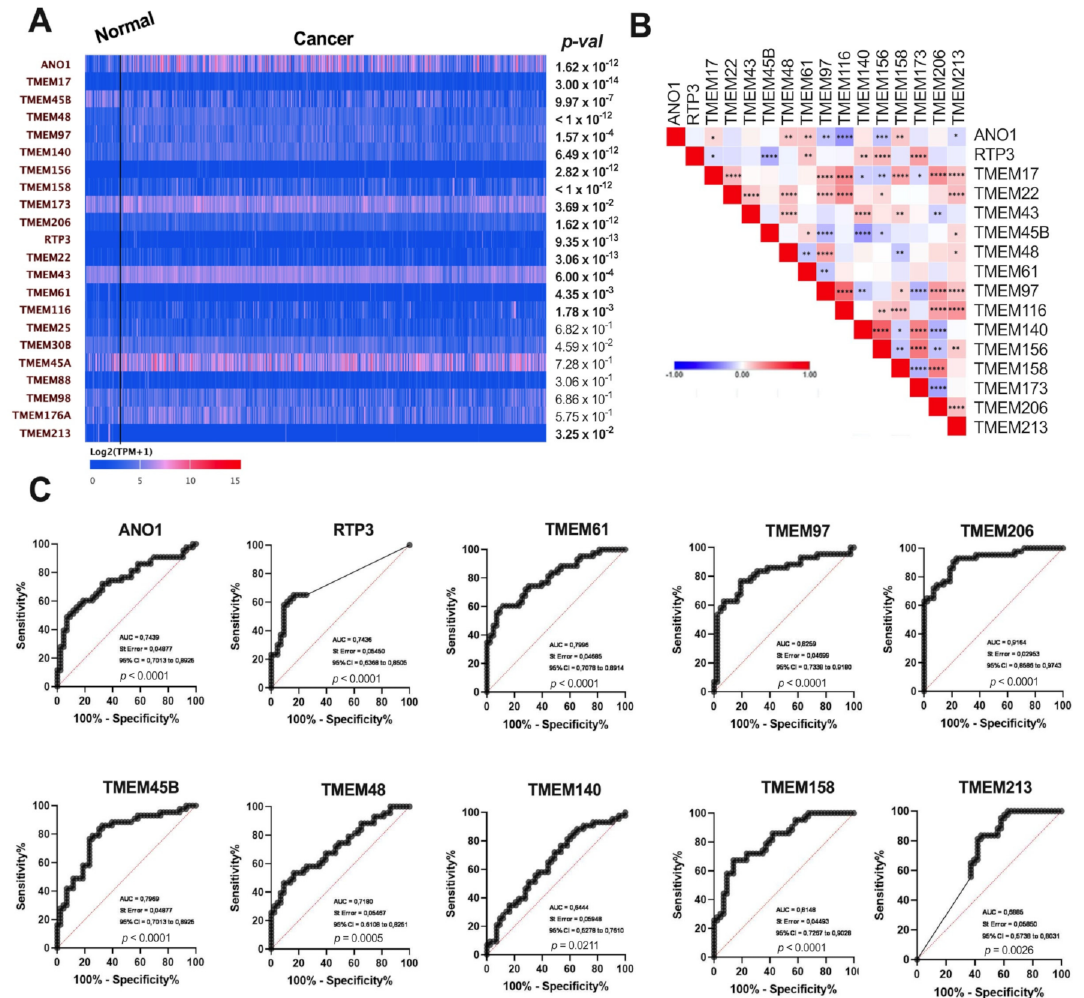
Figure 1. ( A ) Expression levels of selected TMEM s genes in tumor and normal tissue in patients with HNSCC; data from UALCAN presented as log2(TPM + 1); modified; ( B ) Heatmap illustrating correlation between expression levels of 16 selected TMEM s in HNSCC patients; the color of each square indicates the R coefficient value; Pearson’s and Spearman’s correlation tests; * p < 0.05; ** p < 0.01; *** p < 0.001; **** p < 0.0001; empty squares indicate no significant correlation; ( C ) Receiver operating characteristic curve (ROC) analysis of statistically significant ANO1 , RTP3 , TMEM45B , TMEM48 , TMEM61 , TMEM97 , TMEM140 , TMEM158 , TMEM206, and TMEM213 of HNSCC samples and paired adjacent normal